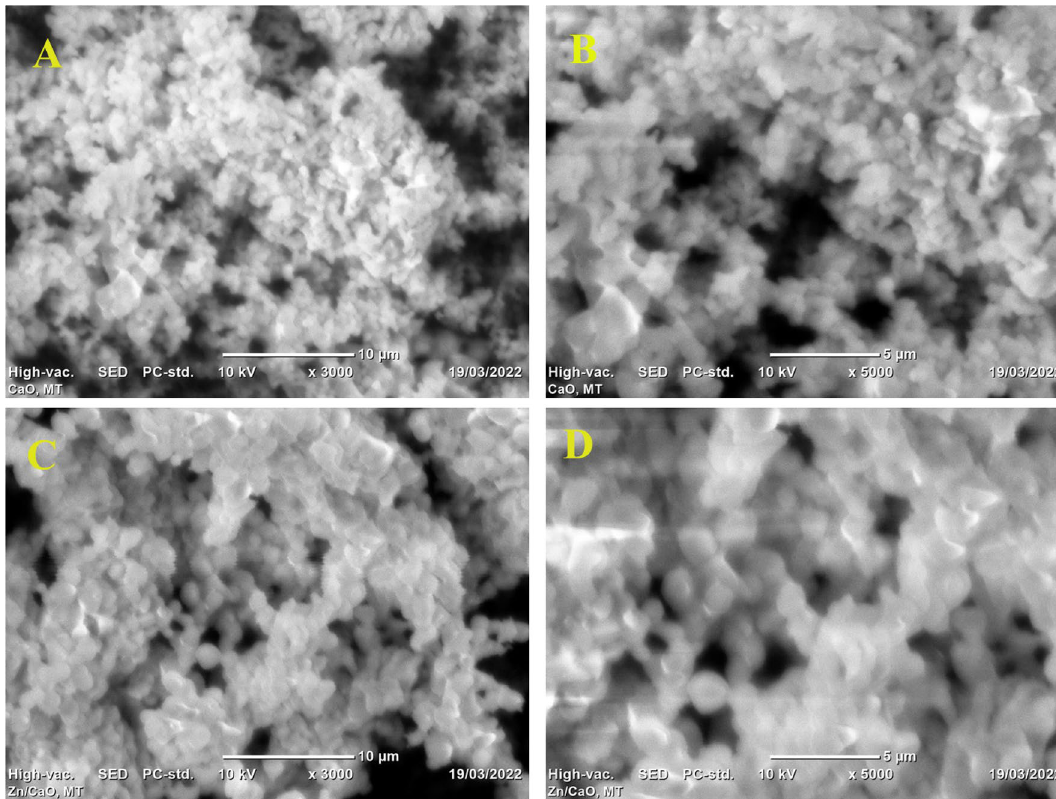
Figure 3. SEM images of lime-based CaO ( A , B ) and 5% Zn-doped lime-based CaO ( C , D ) taken at 10 and 5 µm,